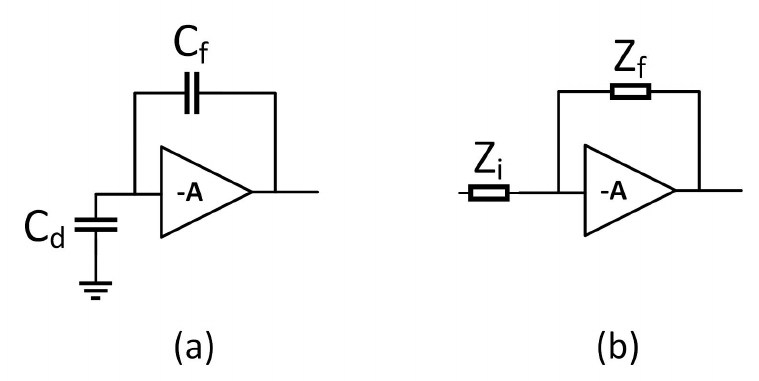
Figure 5. The pixel front end separated into simplified models of the pre-amplfier ( a ) and the shaper ( b ). To determine whether or not a hit has occurred, the output of the shaper is then passed to a comparator as shown in Figure 6. This detects a hit if the incoming signal value has passed an externally set detection threshold. Since manufacturing tolerances mean that the shaper output level and the comparator’s offset will vary slightly from pixel to pixel, each pixel effectively experiences a slightly different threshold. To account for this, a capacitor is placed between the shaper output and the comparator input. The voltage on this capacitor can be set using an in-pixel Digital-to-Analogue Converter (DAC). The value applied to the capacitor allows pixel-to-pixel variations to be tuned out, ensuring that all pixels have the same threshold.